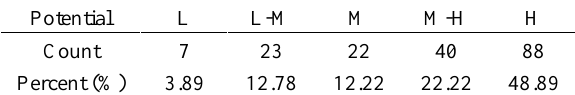
Figure 2. The utilization potential of WER and validation In North America, most of high utilization potential regions are located in central United States and north-eastern Canada. The low utilization potential regions are mainly located in west of North America. Other regions present a medium utilization potential.